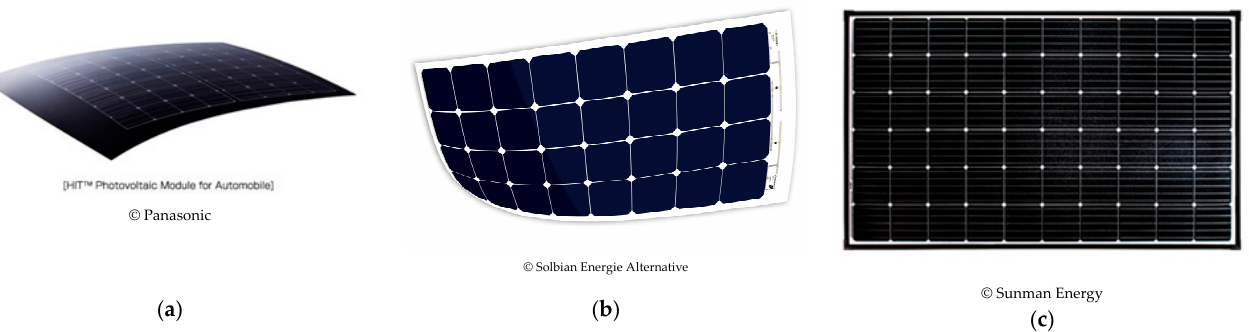
Figure 5. ( a ) Curved Panasonic module for Toyota Prius [74]; ( b ) Solbian flexible solar panels [75]; ( c ) Sunman light solar panel [76].